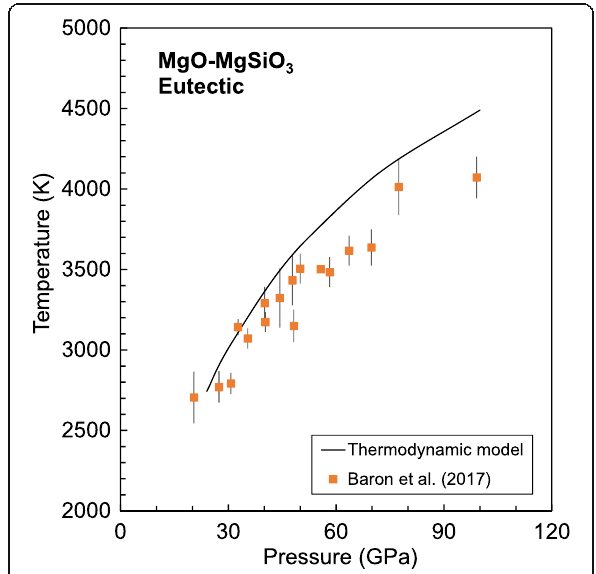
Additional file 1: Figure S1. Pressure calibrations at room temperature (RT) and high temperatures. Fo, Mg 2 SiO 4 , forsterite; Wd, Mg 2 SiO 4 wadsleyite; Rw, Mg 2 SiO 4 ringwoodite; Ak, MgSiO 3 akimotoite; Bdg, MgSiO 3 bridgmanite; Pc, MgO periclase. Pressures of the phase transitions at high temperatures were taken from Morishima et al. (1994), Suzuki et al. (2000), and Fei et al. (2004). The red point at 790 ton, 23 GPa, and 2273 K is 0.55 GPa away from the green curve of 1873 K, which is comparable to the standard deviation of the fitting curves, 0.4 GPa. Figure S2: Heating power-temperature relationships. Figure S3: Melting temperatures of MgO. The black line represents the melting temperatures calculated in this study, and the dashed gray line represents those by de Koker and Stixrude (2009). The melting temperatures determined by high-pressure experiments and ab initio calculations are also plotted: orange squares, Zerr and Boehler (1994); green triangles, Alfe (2005); blue circles, Zhang and Fei (2008); purple squares, Du and Lee (2014); and red squares, Kimura et al. (2017). Figure S4: Melting phase diagram in the MgO – MgSiO 3 system at 24 GPa. The black line represents the phase boundary calculated in this study, and the gray line represents that by Liebske and Frost (2012). The experimental data by Liebske and Frost (2012) are also plotted, where the red circle represents the composition of liquid above liquidus, the green squares represent liquid coexisting with periclase (Pc), the orange squares represent liquid coexisting with bridgmanite (Bdg), and the diamonds represent subsolidus phases. Interaction parameter updated by Ohnishi et al. (2017) was used to calculate the phase relations. Figure S5: X-ray diffraction patterns of the run products. The black short bars beneath the curves denote the peak positions of bridgmanite (Bdg) and rhenium (Re). (PDF 1046 kb)